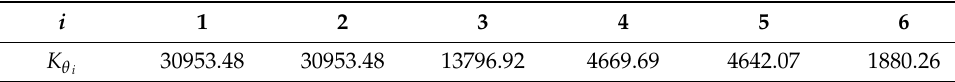
Table 5. The joint stiffness values of each joint for the robot. (N ·